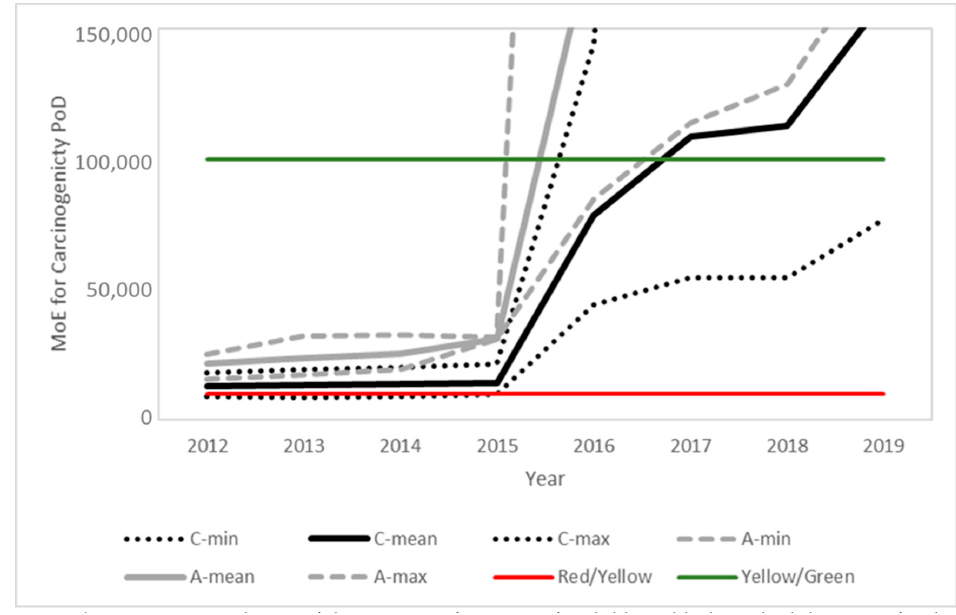
Figure 5. Time evolution of the margins of exposure for children (black) and adults (grey) for the carcinogenicity PoD predicted from the food monitoring data. Solid lines represent the mean value and dotted lines the maximum and minimum values for children (C) and adults (A), respectively. Color lines indicate the thresholds between the risk levels (see Section 4 for details).